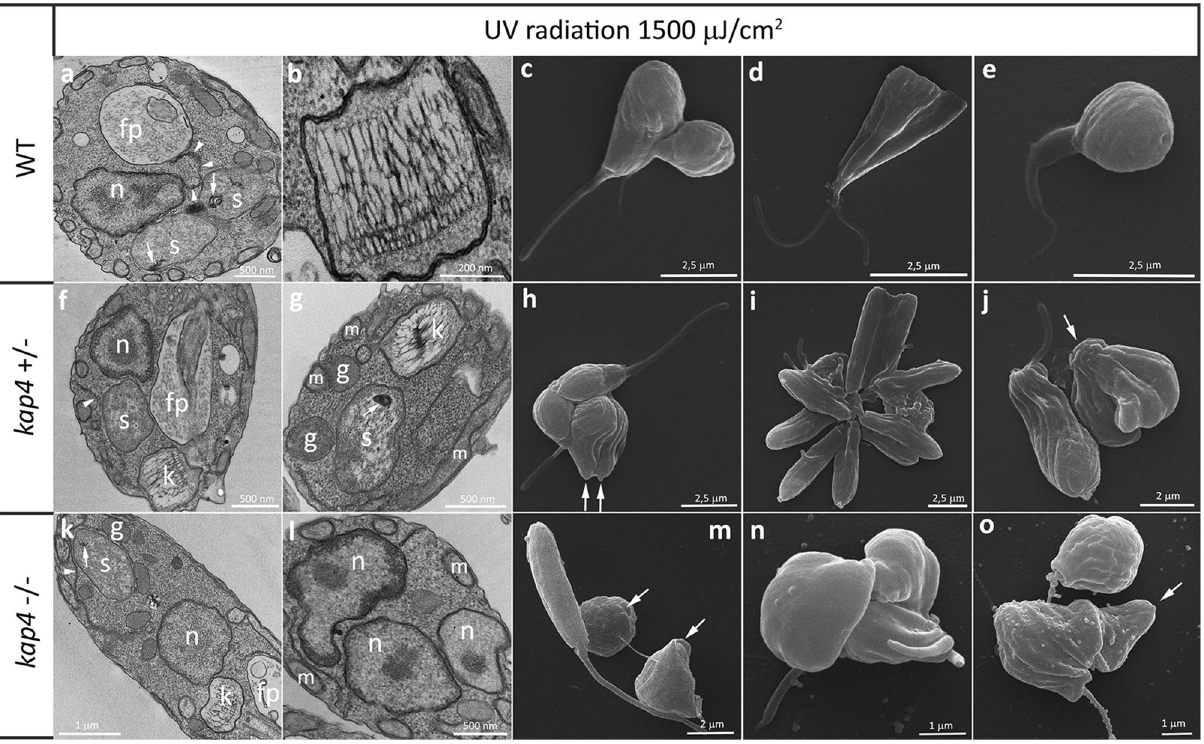
Figure 7. Effects of UV irradiation on the ultrastructure of WT and mutant cells as revealed by TEM ( a , b , f , g , k , l ) and SEM ( c – e , h – j , m – o ). ( a , b ) WT cells submitted to irradiation. Nuclear DNA condensation and kDNA arrangement were not modified. However, the symbiont genome became densely packed ( a , arrows). ( f , g , k , l ) mutant cells submitted to UV irradiation. Nuclear DNA condensation and kDNA arrangement were not affected. ( f , k , g ) The symbiont was seen in association with the ER (white arrowheads), and its DNA suffered condensation (white arrows). ( l ) kap4 −⁄− cells containing multiple nuclei were also observed. fp flagellar pocket, g glycosome, k kinetoplast, m mitochondrion, n nucleus, s symbiont. ( a – c ) WT cells subjected to irradiation presented atypical formats indicating cytokinesis impairment. ( h – j ) kap4 +⁄− cells submitted to UV irradiation presented multiple interconnected cell bodies, indicating that in such mutants, cytokinesis impairment was exacerbated in relation to WT protozoa. ( m – o ) kap4 −⁄− cells submitted to UV irradiation presented a round cell body, and the flagellum was short or even absent (white